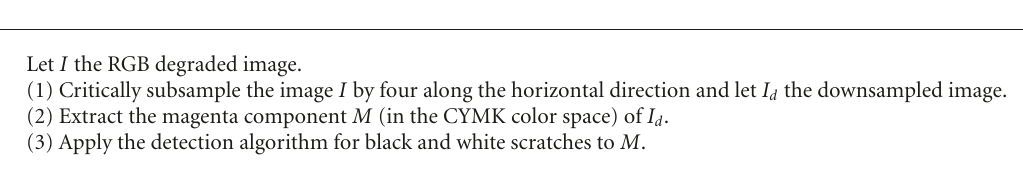
Algorithm 2: Algorithm for the detection of color